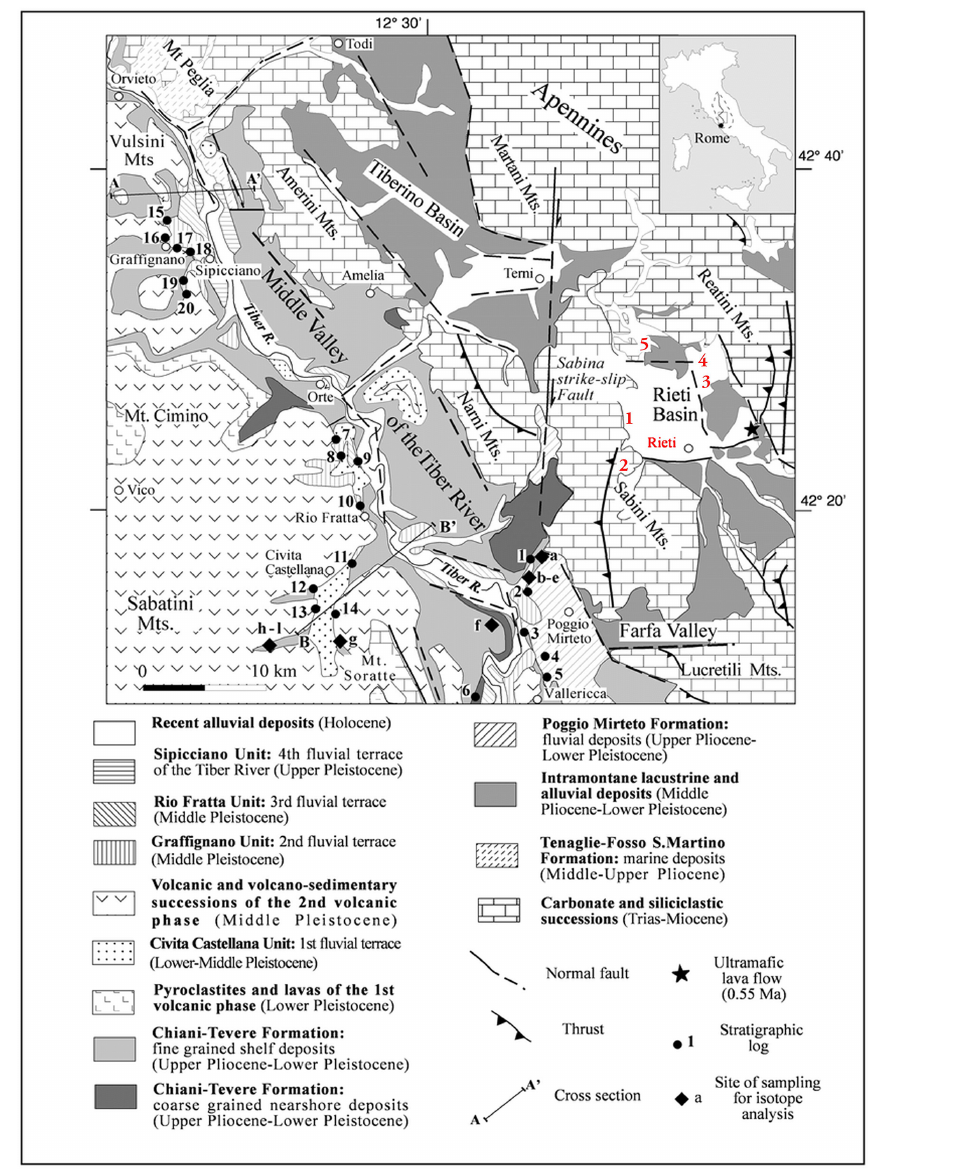
Figure 5. Franciscan monasteries (in red), including (1) Greccio, (2) Santuario di Fonte Colombo, (3) Santuario della Foresta, (4) Poggio Bustone and (5) Labro. After Mancini and Cavinato